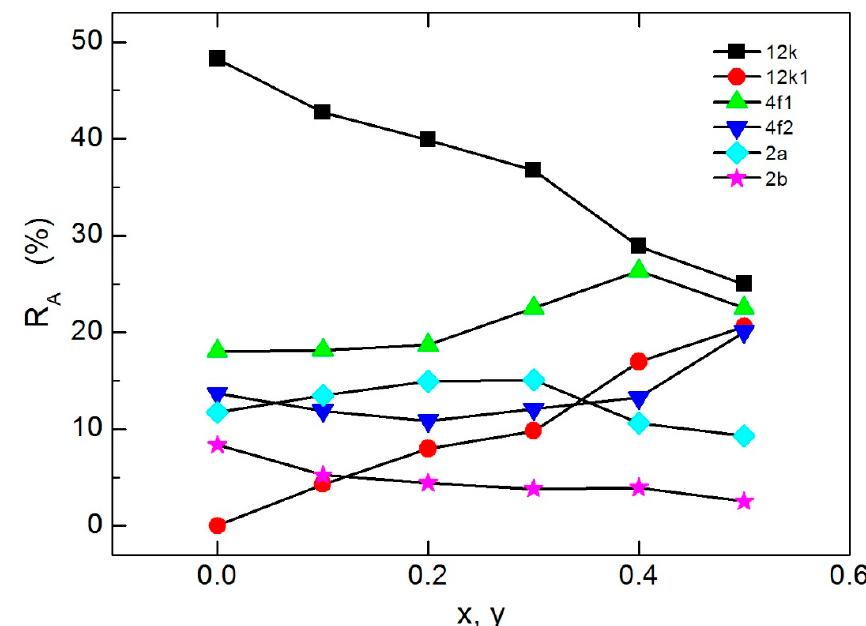
Figure 7. Mn and Y contents dependent relative area variation of Sr 1 − x Mn x Fe 12 − x Y x O 19 (0.0 ≤ x ≤ 0.5) nanohexaferrites.